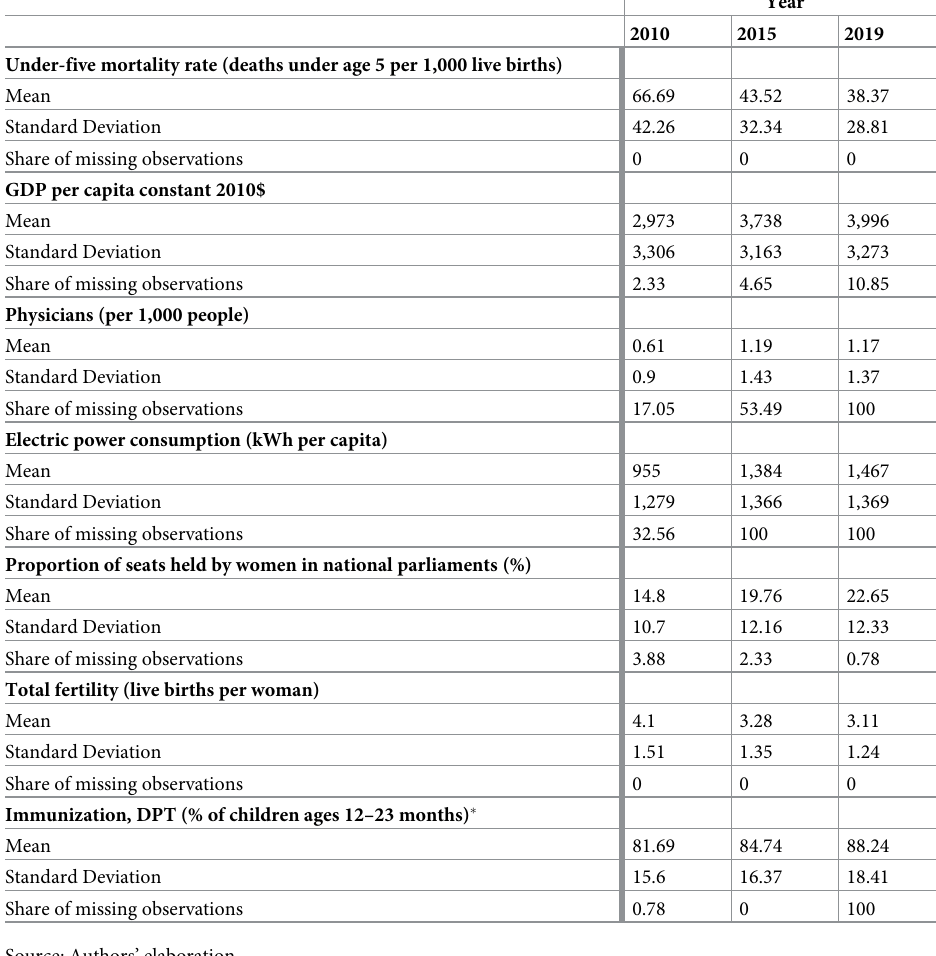
Table 1. Descriptive statistics of main variables in the sample of 129 LMIC countries (values prior to